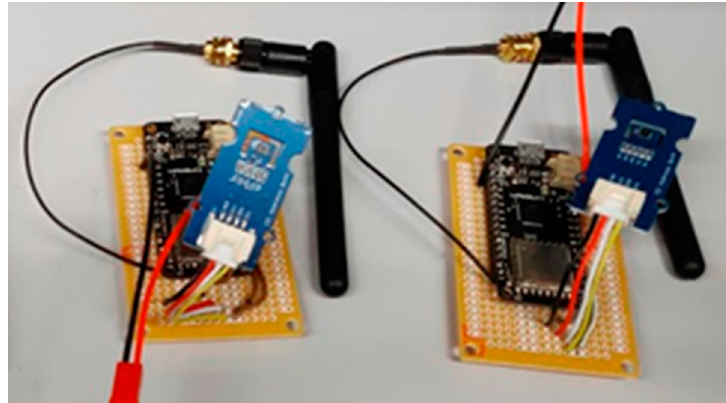
Figure 4. Prototypes of LoRa nodes for the data centre in the process of completion.